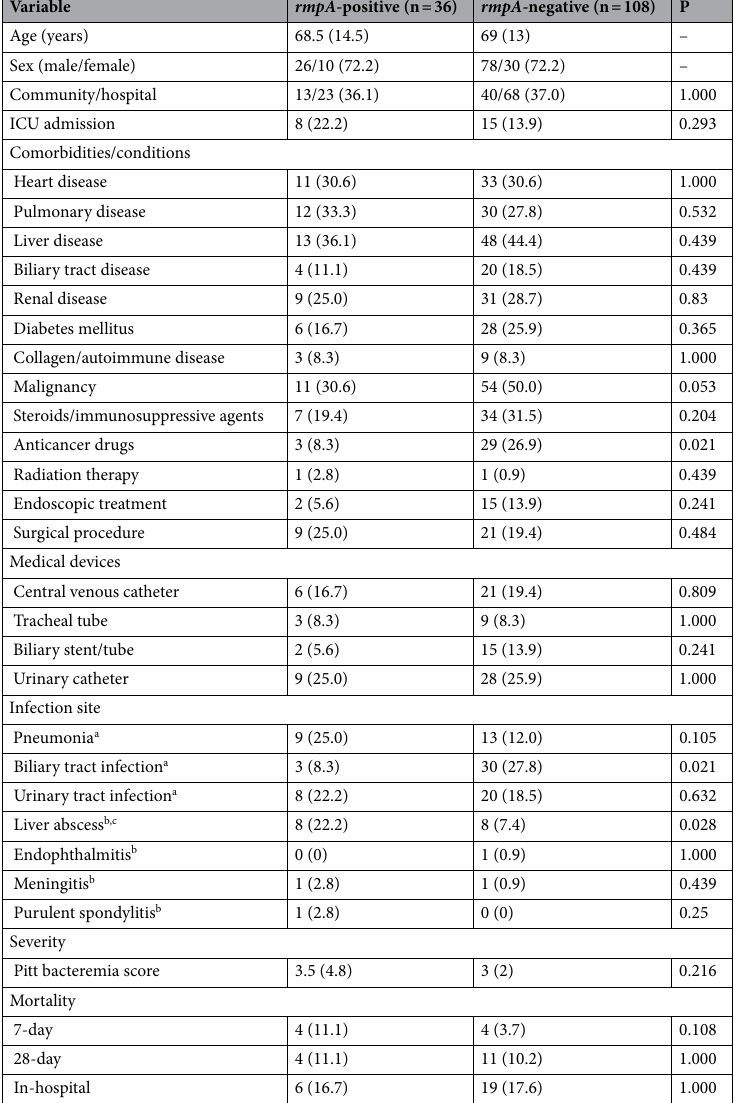
Table 4. Clinical characteristics of bloodstream infections caused by rmpA -positive and rmpA -negative K. pneumoniae . Data are expressed as median (interquartile range) or number (%). a Clinical diagnosis with